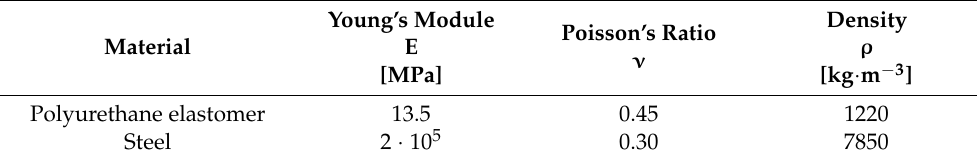
Material Table 1. Material constants of polyurethane elastomer and steel used for numerical calculations. Density Young’s Module Poisson’s Ratio ρ Material E ν [kg · m − 3 ] [MPa] Polyurethane elastomer 13.5 0.45 1220 Steel 2 · 10 5 0.30 7850